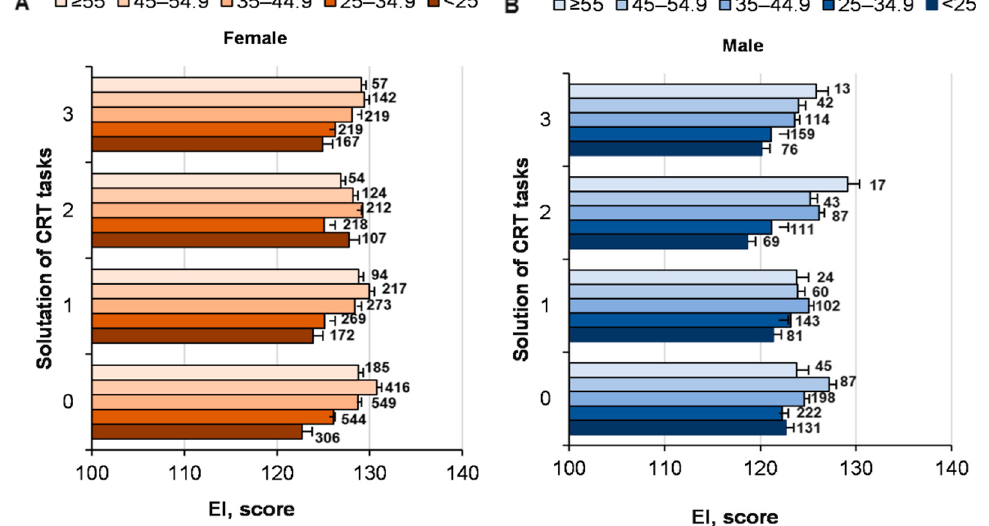
Figure 7. The EI of men and women of different ages in solving CRT tasks. At the top of the column is the number of participants. (( A )—women of different ages EI score and solutions of CRT; ( B )—men of different ages EI score and solutions of CRT).